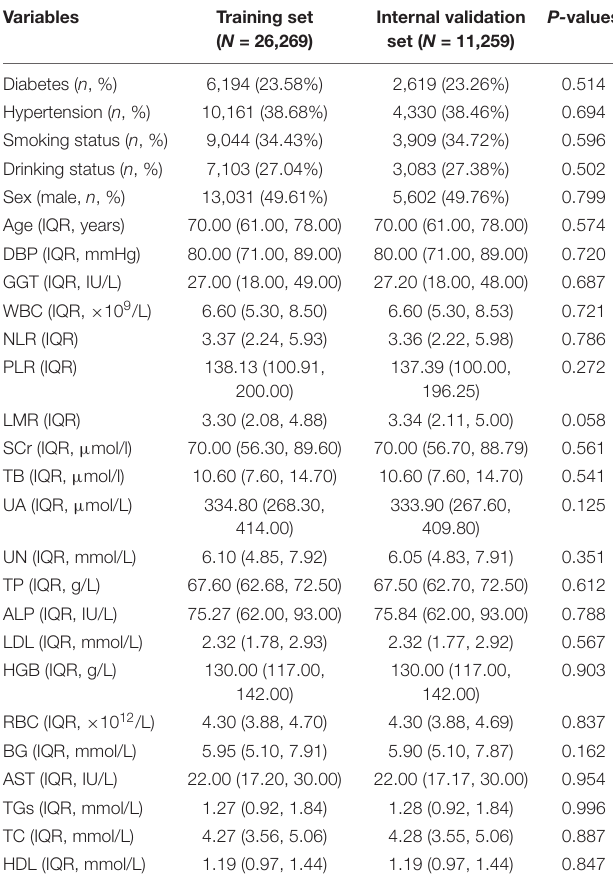
TABLE 2 | Demographic and clinical characteristics of the training and internal validation sets. Variables Training set